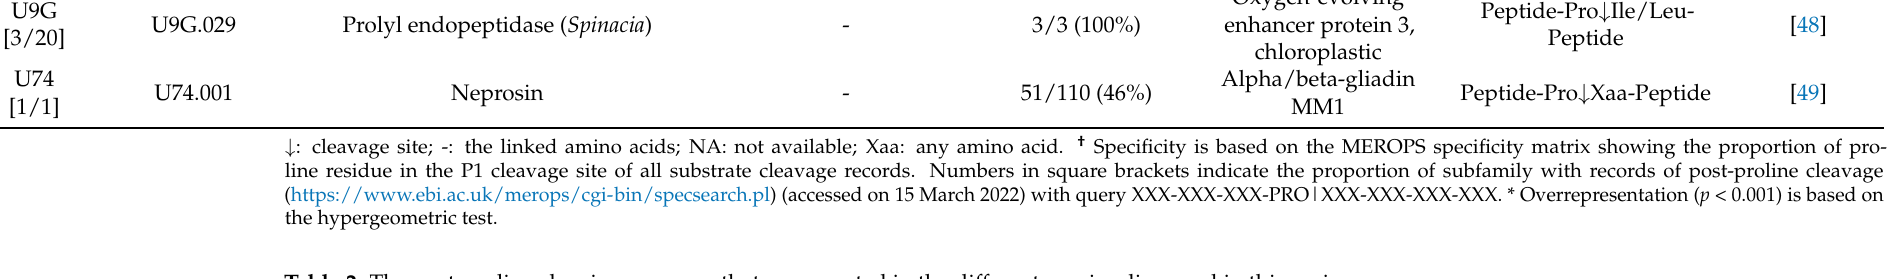
Table 2. The post-proline cleaving enzymes that are reported in the different species discussed in this